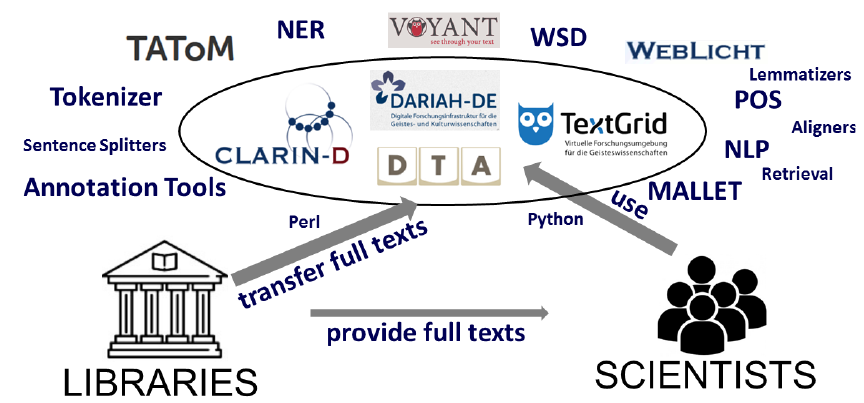
Fig. 8 Full text transfer between libraries, scientists and research infrastructures (and software